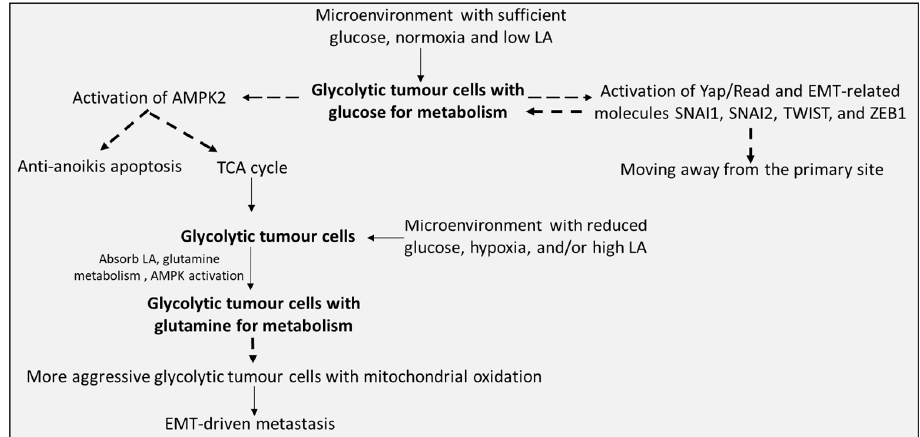
Figure 6. Effects of metabolic regulation on tumour metastasis. Glycolysis and Mitochondrial oxidative metabolism jointly contribute to the invasion and migration of tumour cells. Under the condition of sufficient glucose, normoxia, and low LA, glycolytic tumour cells can enable tumour cells to shift to functional mitochondrial oxidation in a manner of activation dependent on AMPK, thus leading to anti-anoikis apoptosis. In addition, glycolytic flux can activate EMT-related molecules SNAI1, SNAI2, TWIST, and ZEB1, and stimulate Yap/YAZ-signaling pathway to drive cell movement. With the starvation of glucose, hypoxia, and increased lactate acid, glycolytic tumour cells can absorb LA and use glutamine for mitochondrial oxidative metabolism. AMPK activated by glycolysis also can enable tumour cells to shift to functional mitochondrial oxidation. The glycolytic tumour cells with glutamine for metabolism showed more aggression, and together with glycolytic tumour cells with glucose for metabolism, both can activate EMT to drive cell metastasis. The dotted arrows represent that there is a multi-step regulatory pathway between the upstream and down- stream of molecular events, which is a brief description rather than one-step regulation.